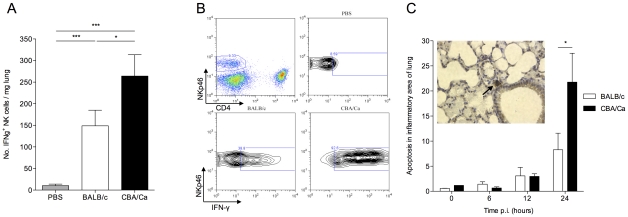
CBA/Ca mice display uncontrolled lung inflammation and associated apoptosis following S. pneumoniae infection.All results are from intranasal-infection of mice with wild-type S. pneumoniae D39. (A) Number of IFNγ+NKp46+CD4− cells per mg lung in PBS-treated or S. pneumoniae-infected BALB/c and CBA/Ca mice at 24 hours p.i. (B) Top left shows gating of NK cells in lung homogenate. Remaining panels show example IFNγ-staining from PBS-treated CBA/Ca or S. pneumoniae-infected BALB/c and CBA/Ca mice at 24 hours p.i. (C) Proportion (%) of apoptotic cells in areas of inflammation within lungs of S. pneumoniae-infected BALB/c and CBA/Ca mice. Inset shows apoptotic cell (arrow) within area of inflammation as defined by presence of inflammatory infiltrate. White bars=BALB/c, black bars=CBA/Ca. *'s indicate significant difference, where *=p<0.05 and ***=p<0.005. For all graphs data represent mean +/− SEM. Results in (A and B) are representative of 3 independent experiments with >4 mice per group. Results in (C) are from a single experiment with 5 mice per group. PBS-treated groups contained both BALB/c and CBA/Ca mice.